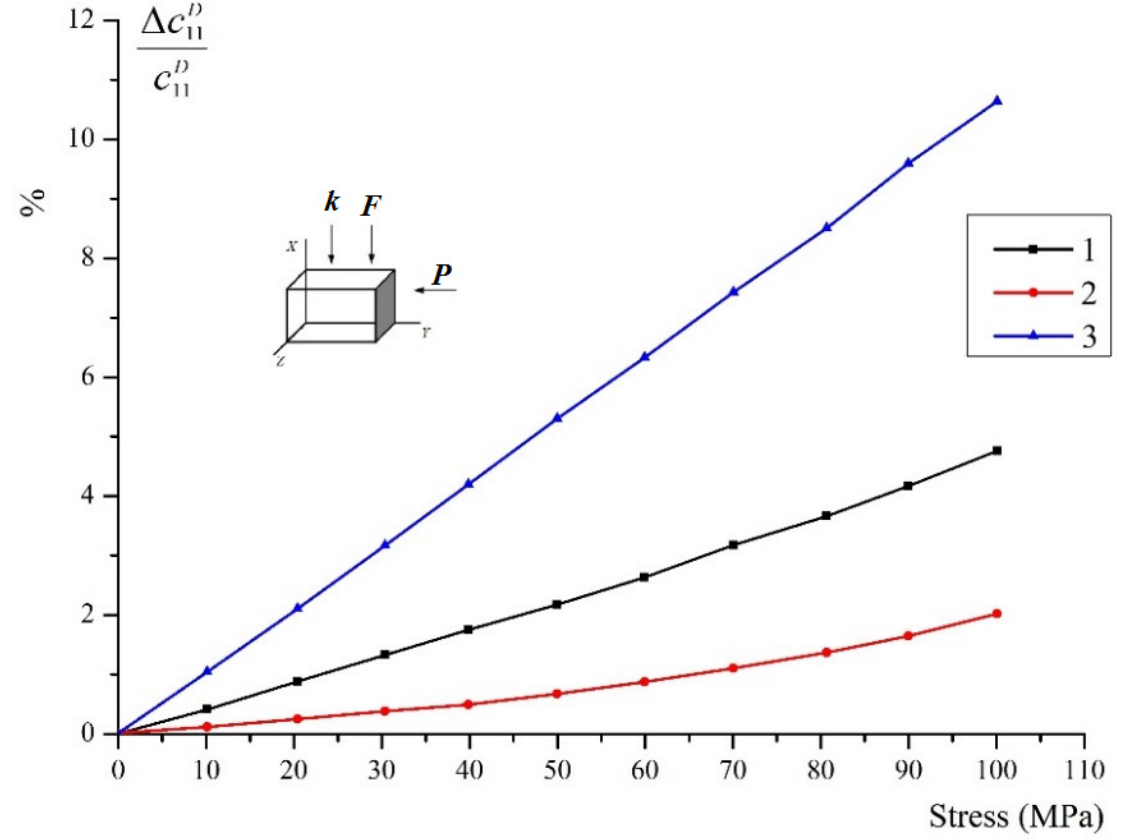
Figure 8. Change in elasticity modulus c D 11